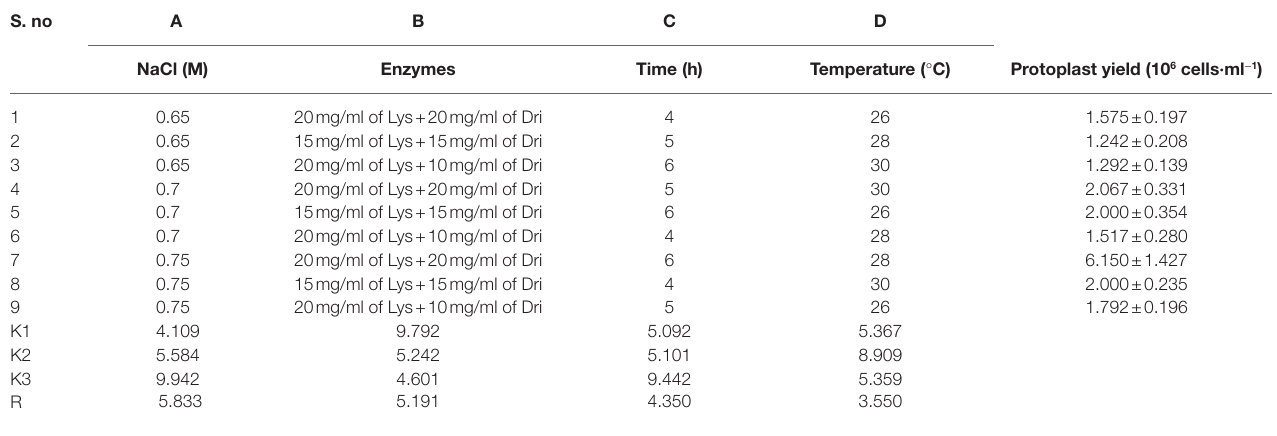
TABLE 4 | The orthogonal experiment results of strain D-1 protoplast